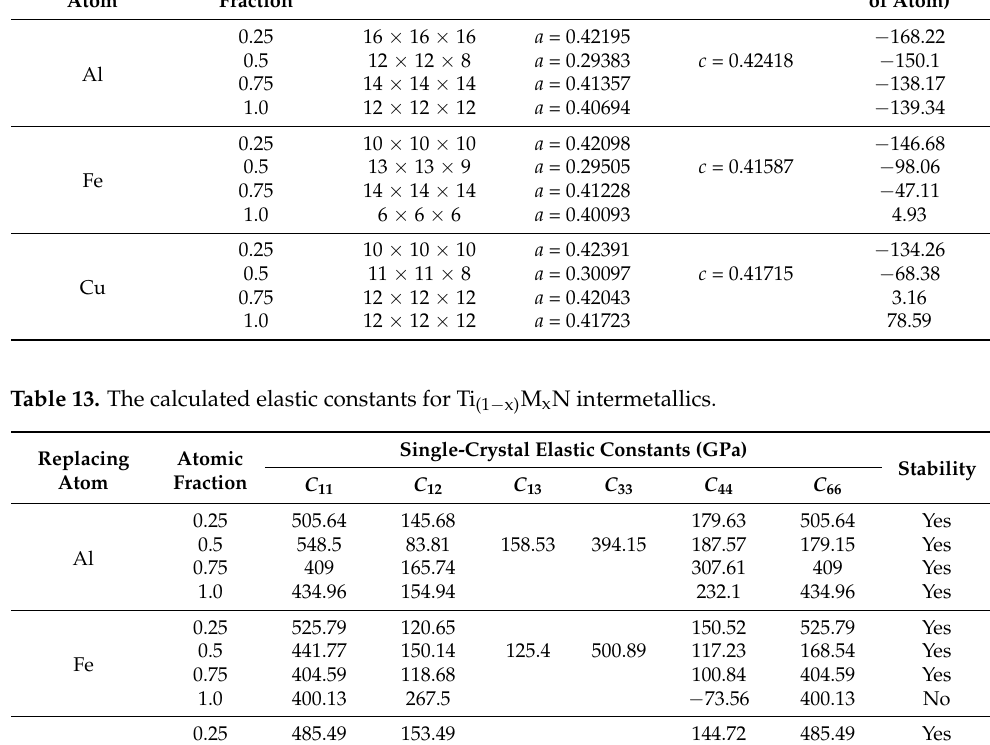
Table 12. The calculated lattice parameters ( a , b , and c in nm) of Ti-N intermetallics. Replacing Atom